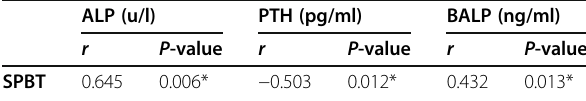
Table 5 Showing the relation between physical performance and serum levels of ALP, BALP, and PTH post-exercise ALP (u/l) PTH (pg/ml) BALP (ng/ml) r P -value r P